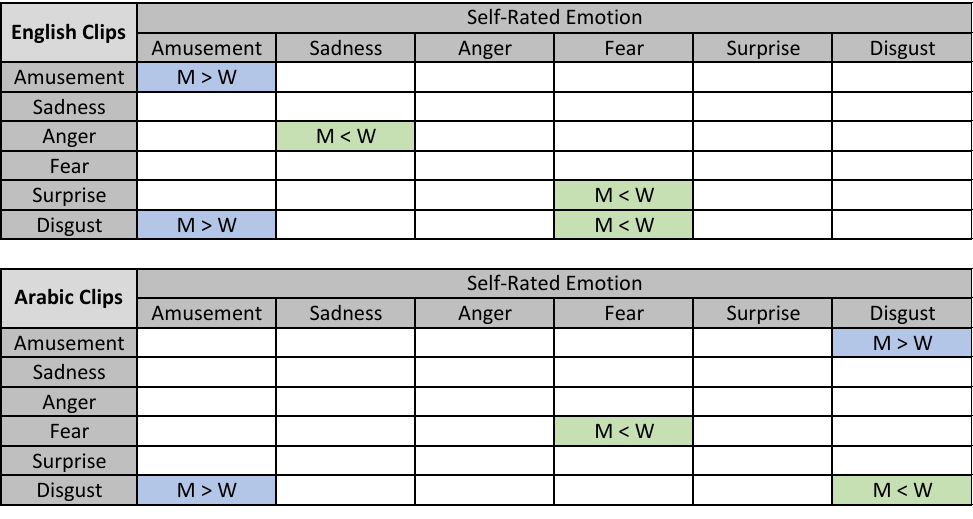
Figure 8. Significant gender differences in self-rated induced emotions from each clip. Using corrected t -test, empty cells indicate no significant differences between the reported